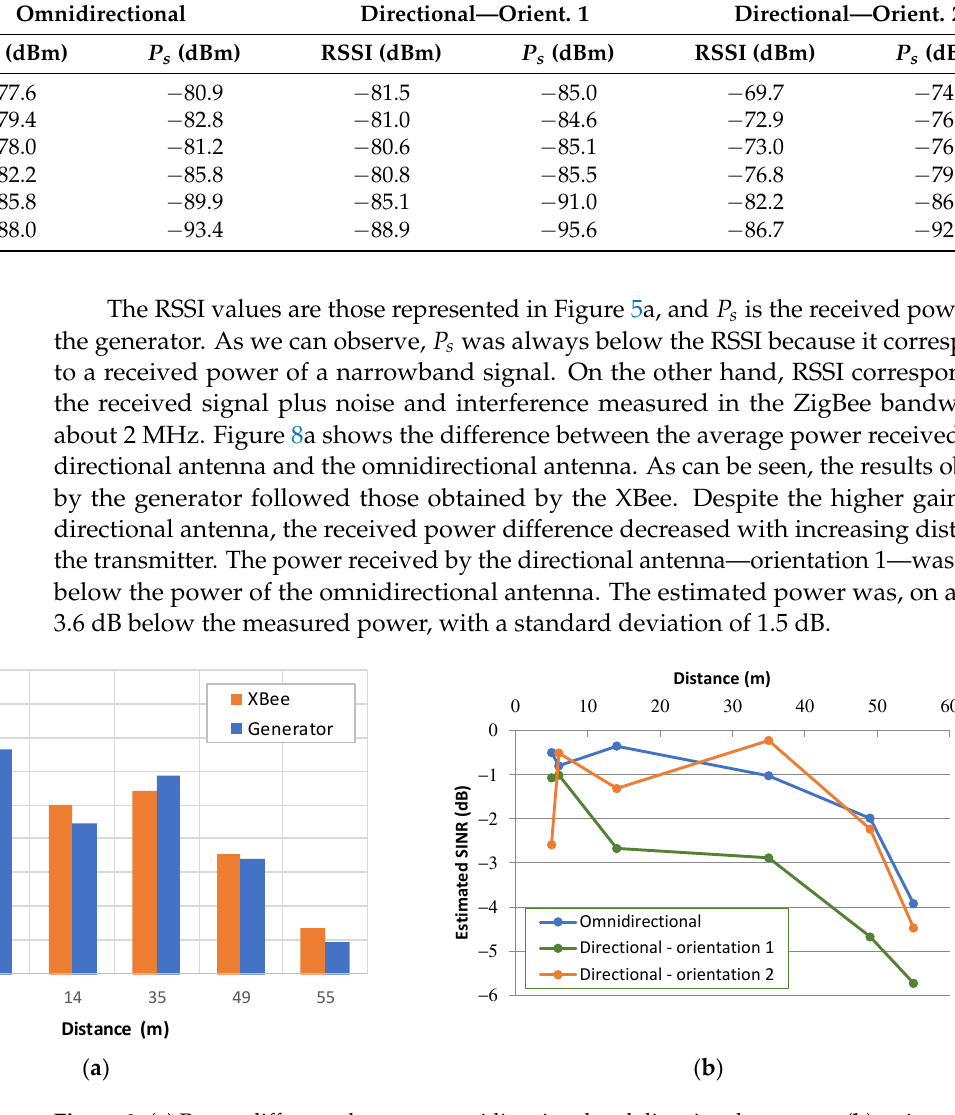
Figure 8. ( a ) Power difference between omnidirectional and directional antennas; ( b ) estimated SNIR.